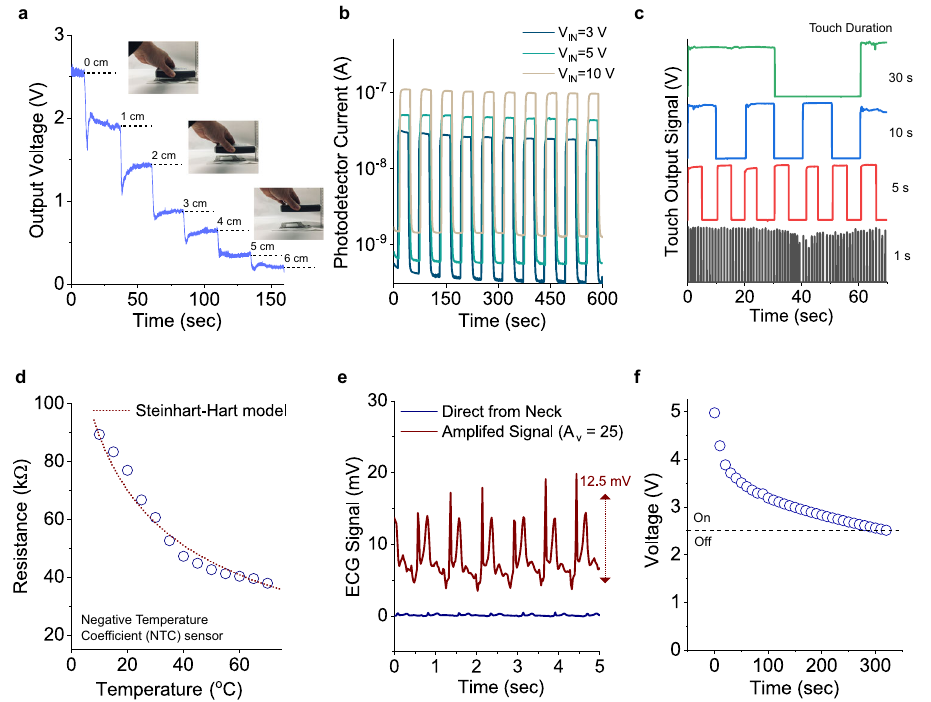
Fig. 2 Characteristic of six F-devices. a F-RF antenna, Output voltage generated from F-RF antenna with a suppressing resistor demonstrates distance- dependent signal classi fi cation. b I light /I dark as a function of time of F-photodetector under various input voltage under UV on and off. c Touch output signal as a function of touch duration. d Negative resistance changes as a function of temperature of Cu 2 O F-temperature sensor. e Ampli fi ed (gain ~ 25) heartbeat by F-biosensor module. f Serially connected fi bre supercapacitors as power switch of textile lighting/display